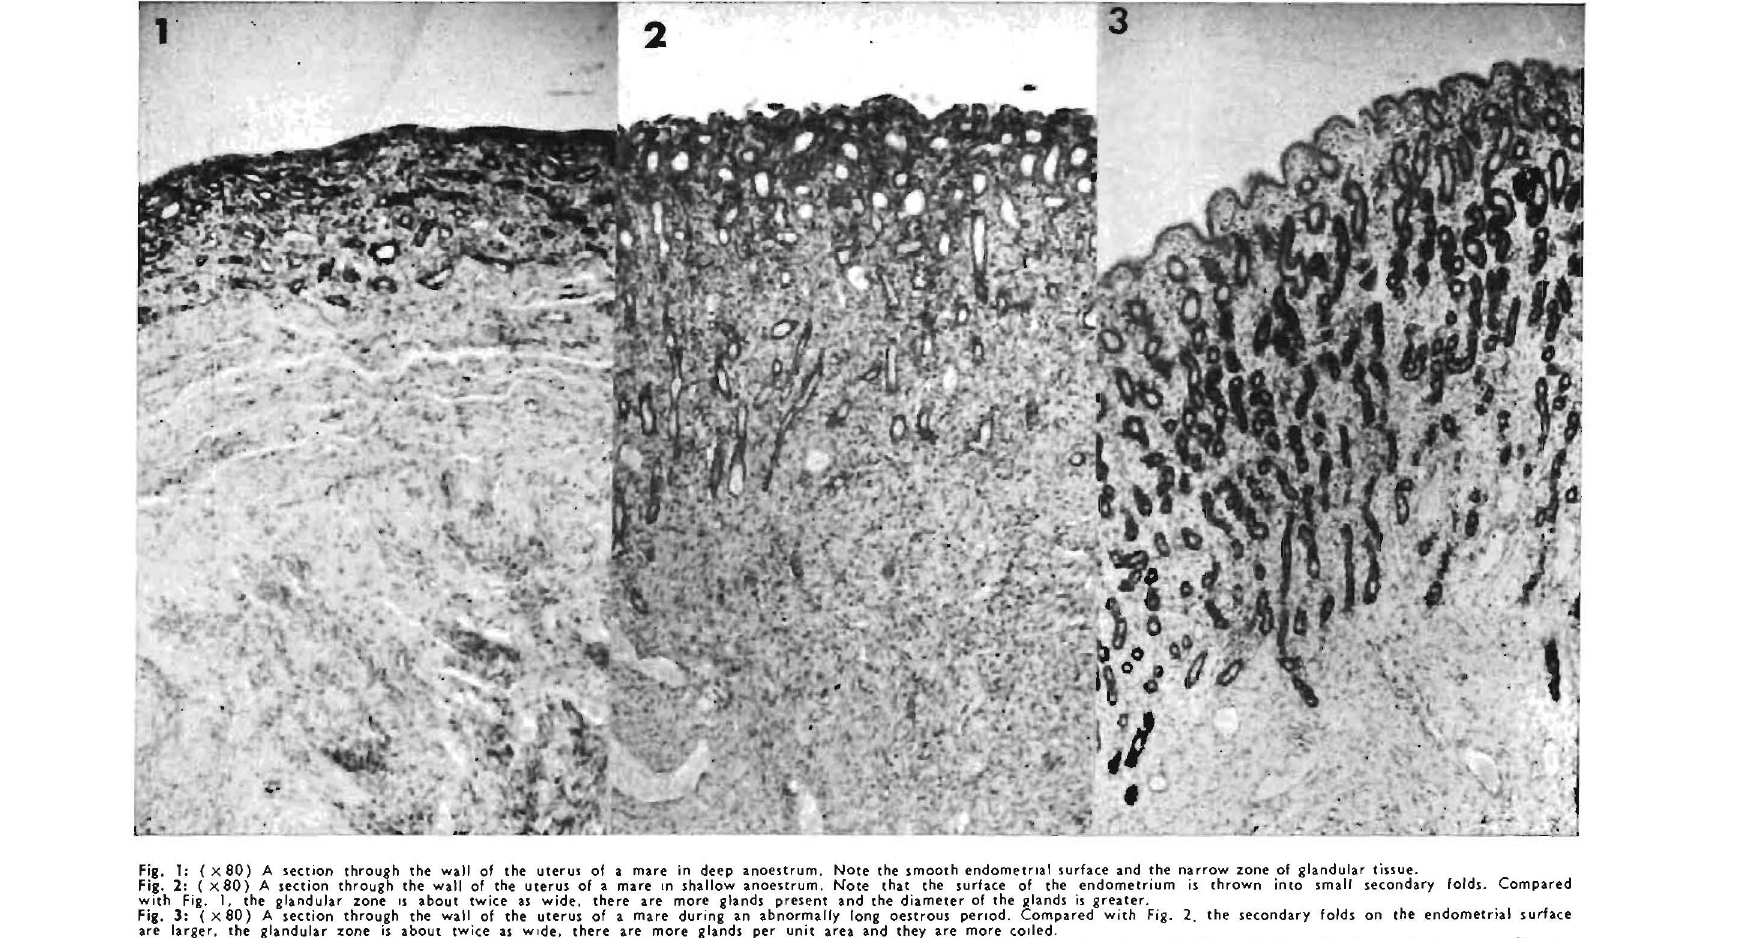
Fig, 1: (x 80) A section through the wall of the uterus of a mare in deep anoestrum. Note the smooth endometrial surface and the narrow zone of glandular tissue. Fig. 2: (x80) A section through the wall of the uterus of a mare In shallow anoestrum. Note that the surface of the endometnum is thrown into small secondary folds. Compared with Fig. I, the glandular zone IS about twice as wide. there are more glands present and the diameter of the jj!lands is greater. Fig, 3: (x 80) A section through the wall of the uterus of a mare during an abnormally long oestrous period. Compared with Fig. 2. the secondary folds on the endometrial surface are larger, the glandular zone is about twice as Wide, there are more glands per unit area and they are more coiled. Fig. 4: (x S 12) A higher magnifIcation of Fig. I. The epithelial cells are cuboidal with a small amount of cytoplasm and small nuclei, The epithelial cells of the glands are small. con densed and stain darkly. Fig .. 5: (x S12) A higher magnification of Fig. 2. Compared with Fig, 4, (he surface epIthelial cells are much higher. being low columnar. The nuclei are large, oval and lie vertIcally to the basement membrane. The diameter of the glands is greater and the epithelial cells are about as large as the surface epithelial cells although their nuclei are smaller. Fig. 6: (x SI~) A higher magnification of Fig. 3. Compared with Fig. S. the surface epIthelial cells layer is higher. now being tall columnar with a large amount of cytopalsm. The large oval veSICular nuclei are more densely packed and lie vertically to the basement membrane. The glandular epithelial cells are smaller than the surface cells. but somewhat larger than the glandular cell. of Fig.